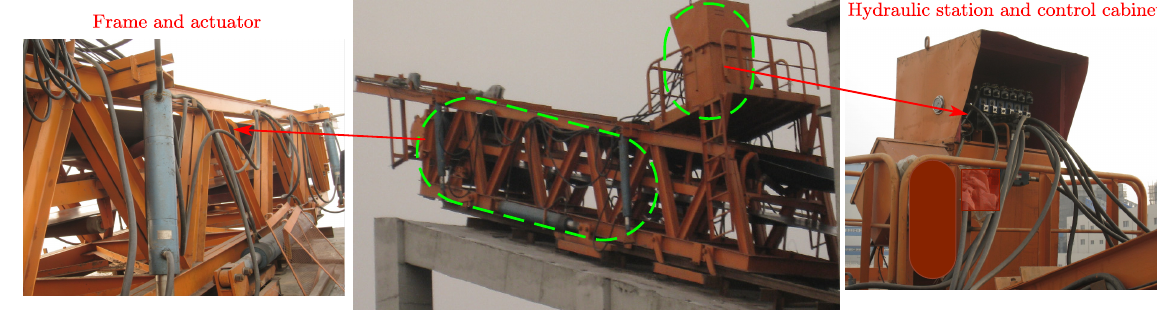
Figure 6. Coal gangue conveying equipment.